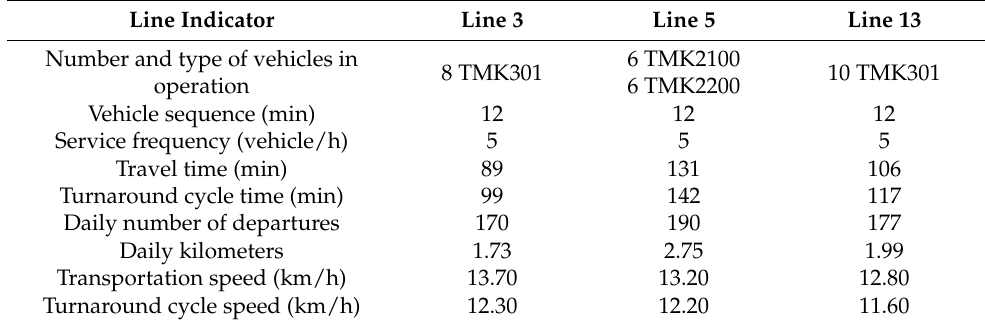
Table 4. The indicators for tram lines 3, 5, and 13 on a characteristic working day during autumn, winter, and spring